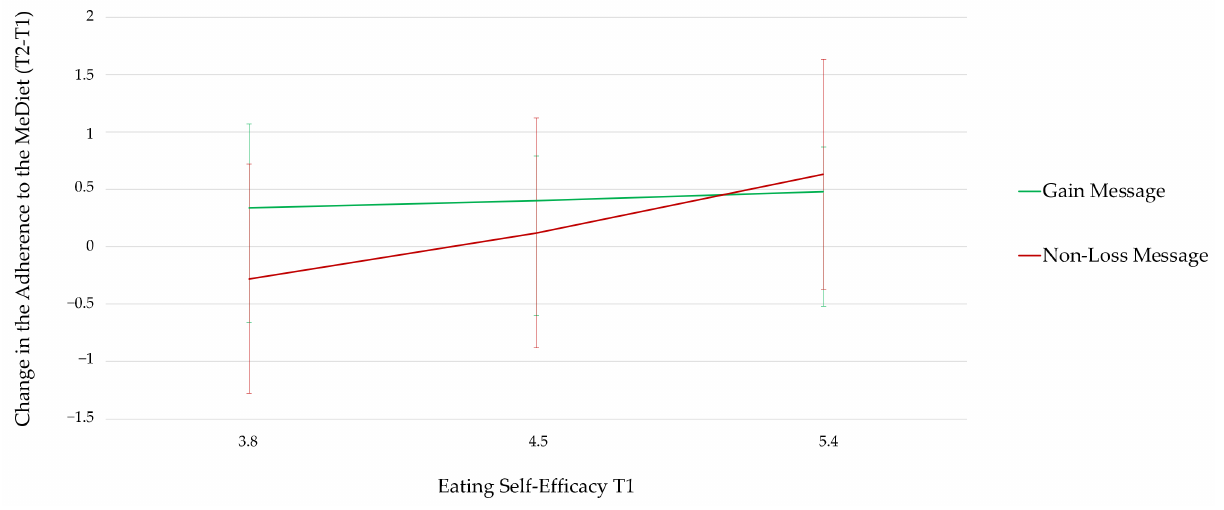
Figure 2. Change in the adherence to the MeDiet according to message framing conditions and participants’ level of eating